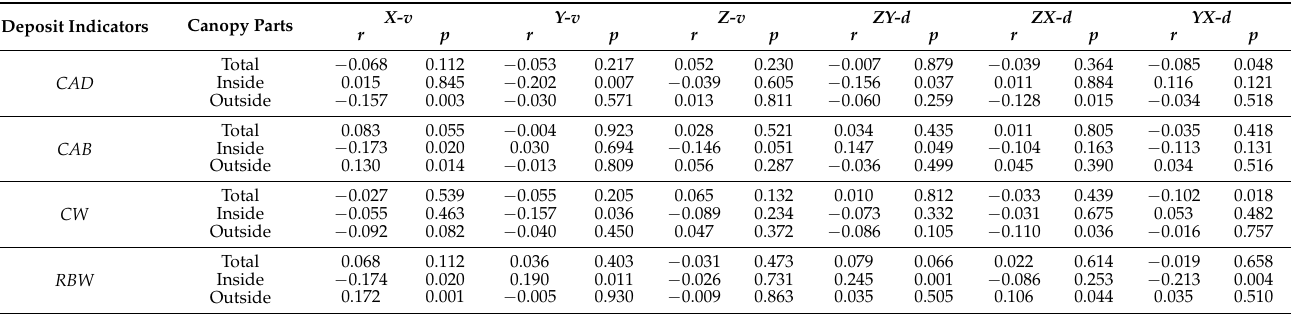
Table 6. Results of the correlation analysis between airflow and deposit indicators at different parts of cherry